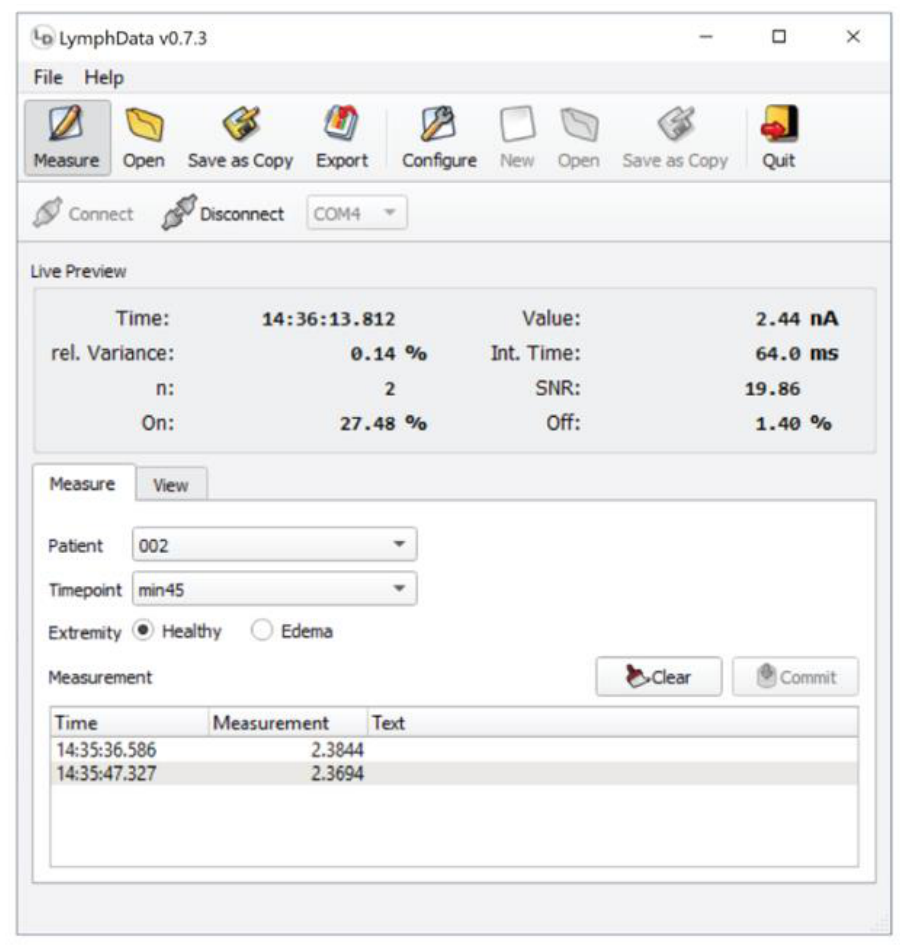
Figure 1. Custom LymphData software used in the clinical study to record the measurements and export them in the format suitable for direct export into eCRF. The LymphMeter is connected to the LymphData software via Bluetooth.